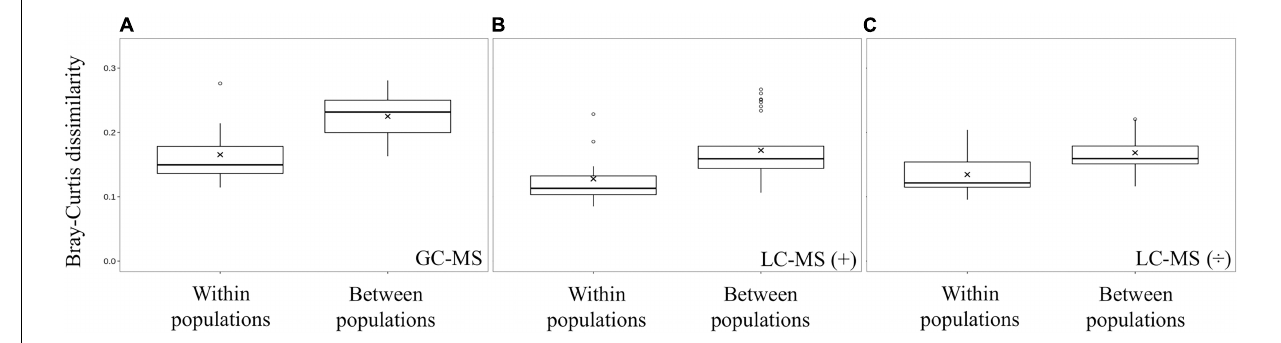
FIGURE 4 | Beta diversity in metabolite profiles within populations and between populations. Boxplots were made from Bray-Curtis dissimilarities calculated on average relative abundance metabolite data from GC-MS (A) , LC-MS positive mode (B) , and LC-MS negative mode (C) data. In all three methods, metabolite profiles within a population were significantly less different ( t -test; p < 0.05) than between populations (GC-MS p = 2.50 × 10 − 5 , LC-MS positive mode p = 4.40 × 10 − 3 , and LC-MS negative mode p = 1.13 × 10 − 3